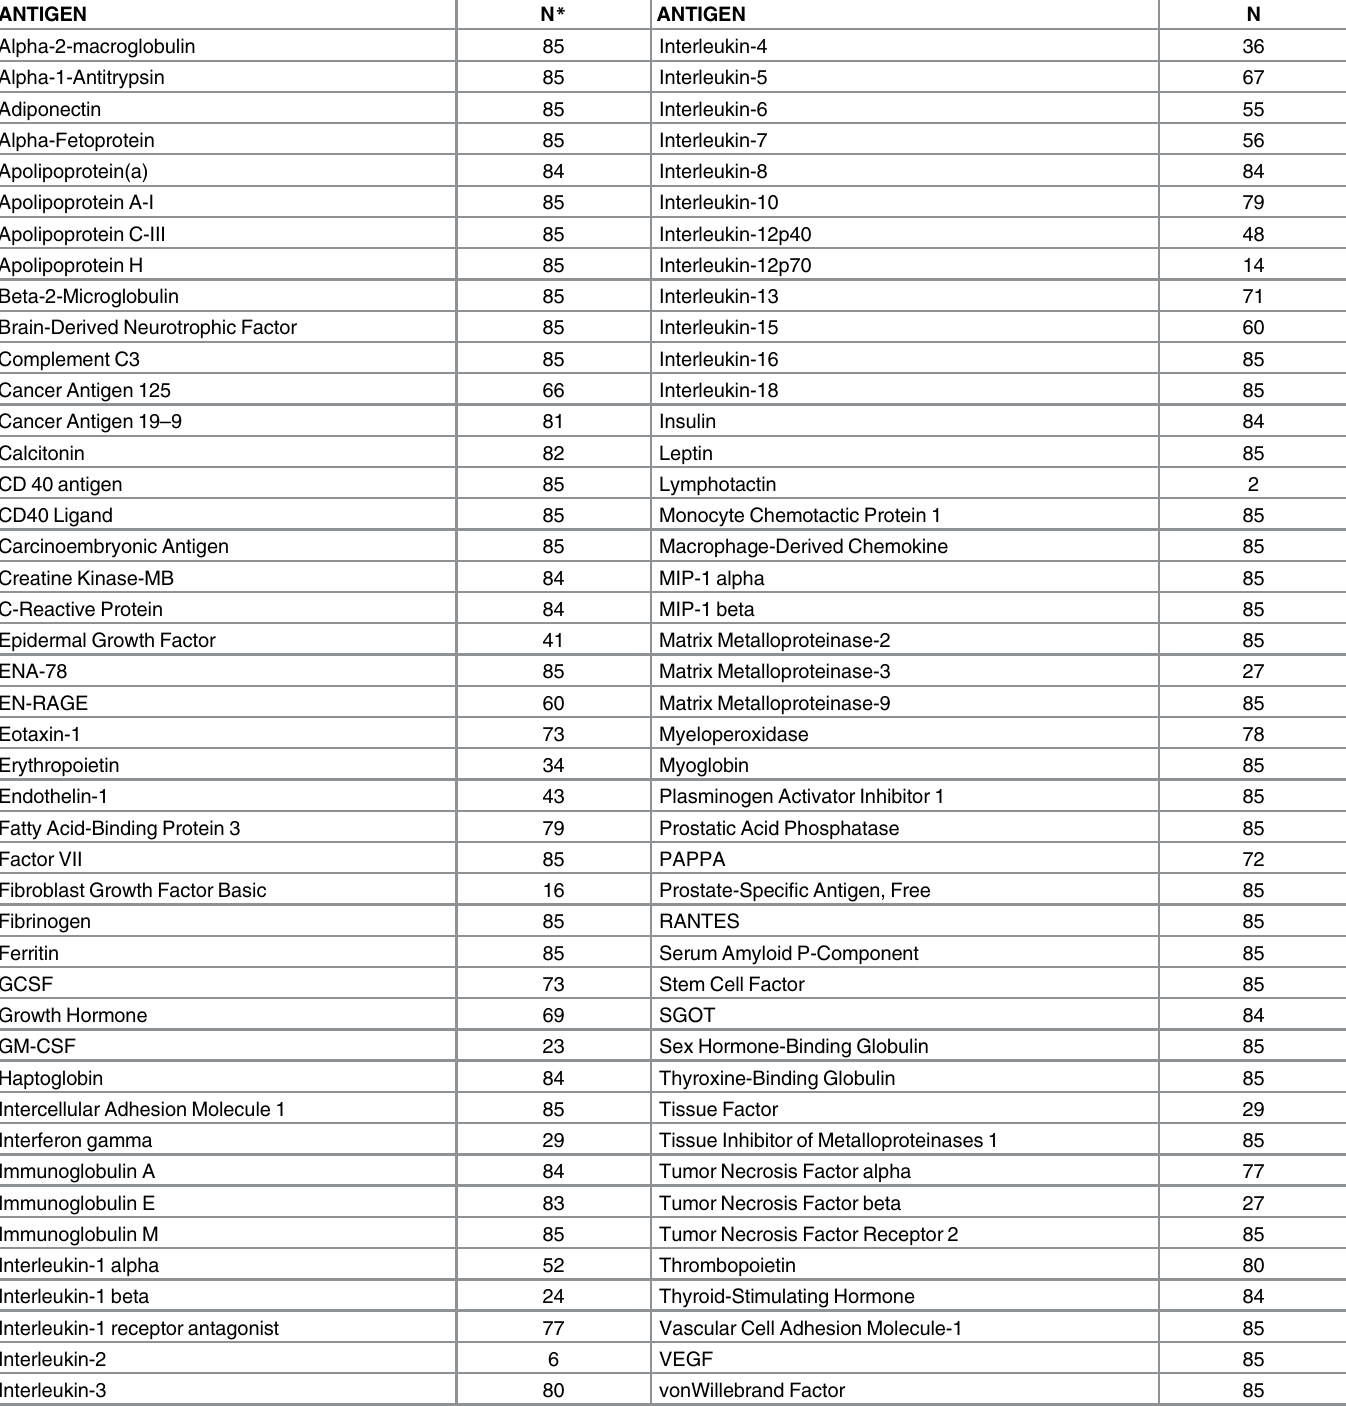
Table 1. HumanMAP 1 v.1.6 analysis by Myriad RBM, Austin TX,